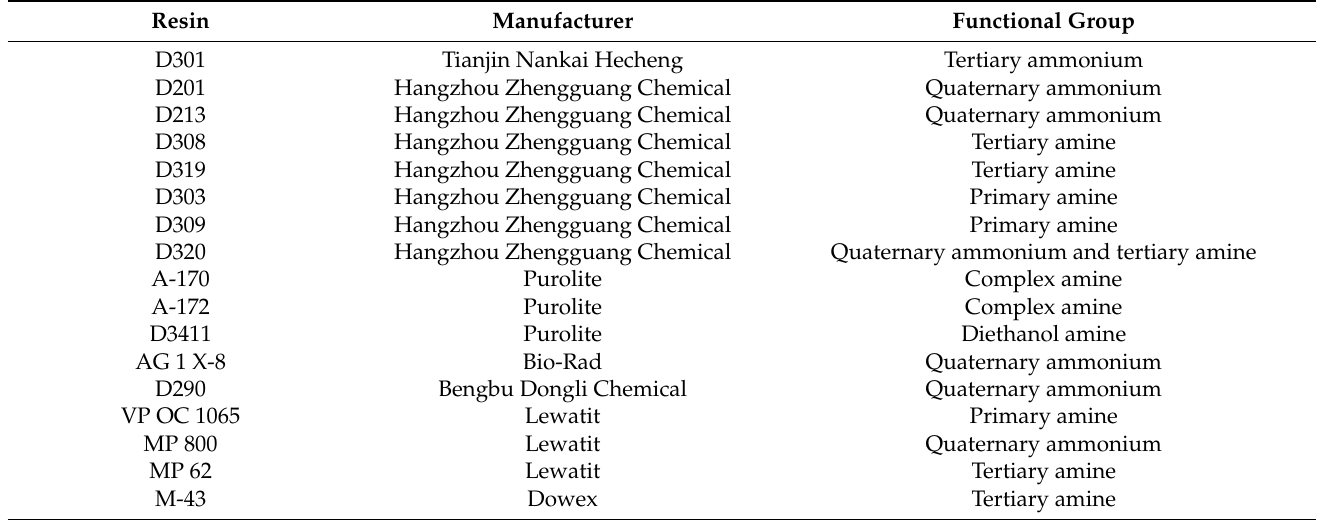
Table 8. Compilation of anionic ion exchange resins tested for molybdenum removal from aqueous